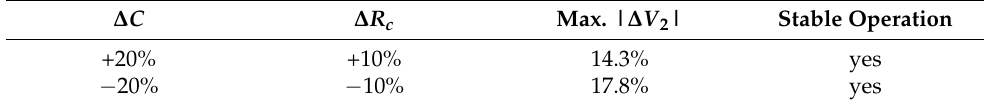
Table 5. Results of robustness analysis against variations of C and R c in Scenario #1.